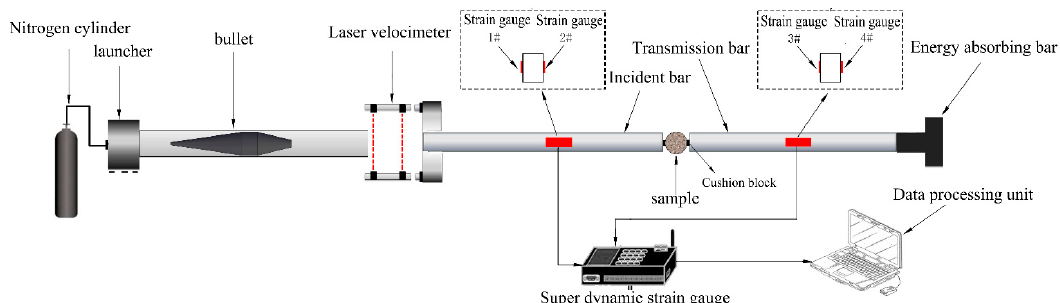
Figure 4. Schematic diagram of the SHPB device for the dynamic splitting test.